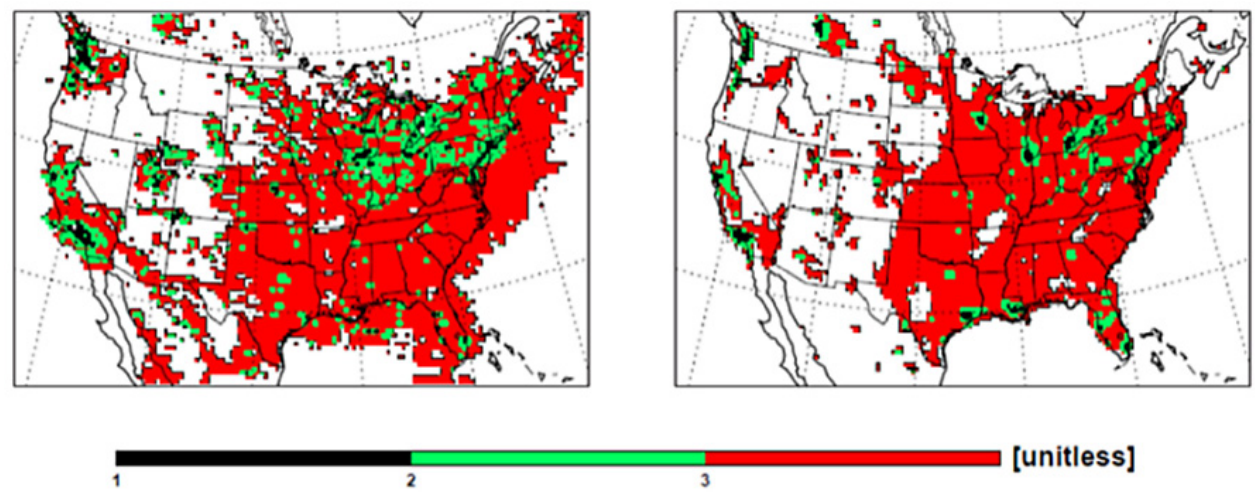
Fig. 3. Three GOME-2-derived and CMAQ-derived chemical regimes using two transitions (1 and 2, see Fig. 2) using the ratio of the GOME- 2 HCHO to NO 2 (left panel) and the CMAQ HCHO to NO 2 column density (right panel). The CMAQ ratios are estimated at the overpass time. Black represents the category 1 region (HCHO/NO 2 < 1, an NO x -saturated regime), green the category 2 region (1 < HCHO/NO 2 < 2, a mixed regime), and red the category 3 region (HCHO/NO 2 > 2, an NO x -sensitive regime). The cell size of the GOME-2 HCHO and NO 2 column density data (from http://www.temis.nl/airpollution/) differs from that of CMAQ (12km), and thus, both GOME-2 and CMAQ column density data are interpolated into 36km for this comparison. Ratios are estimated only when the GOME-2 NO 2 column density is larger than 1.0 × 10 15 moleculescm − 2 .